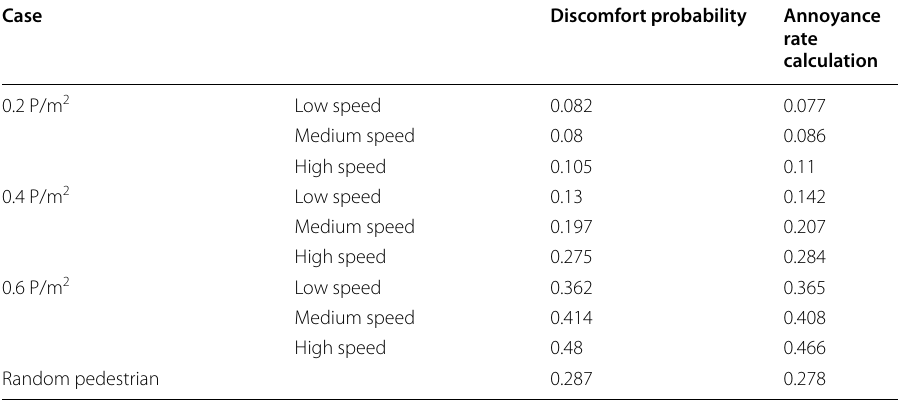
Table 4 Comparison of the discomfort probability values and annoyance rate values